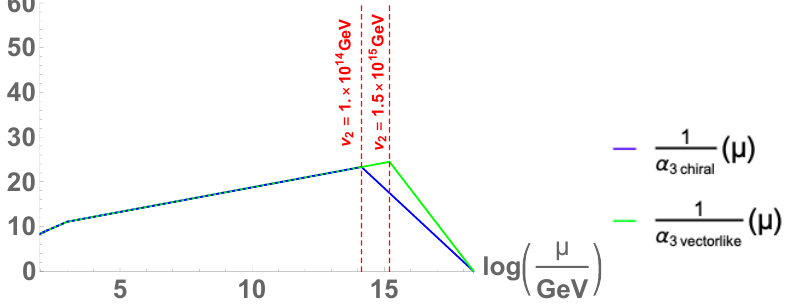
Figure 5 . Running coupling constant of SU(3) C in model A when v 2 = 10 14 GeV, and in its gauged vector-like counterpart with six triplets when v 2 = 1 : 5 (cid:2) 10 15 GeV, assuming m soft = 1